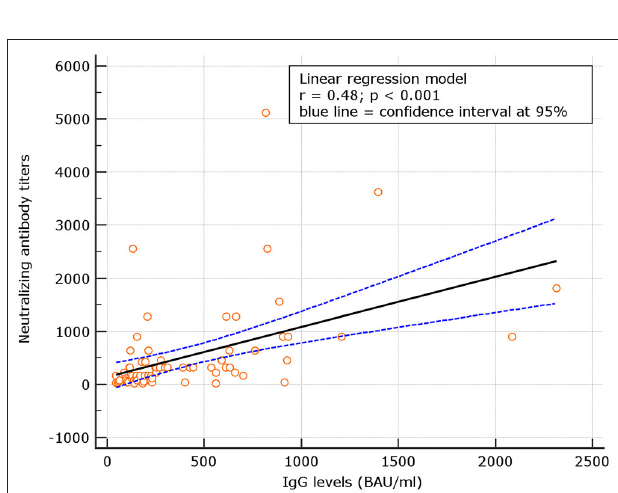
FIGURE 5 | Correlation between neutralizing antibody titers and IgG levels among